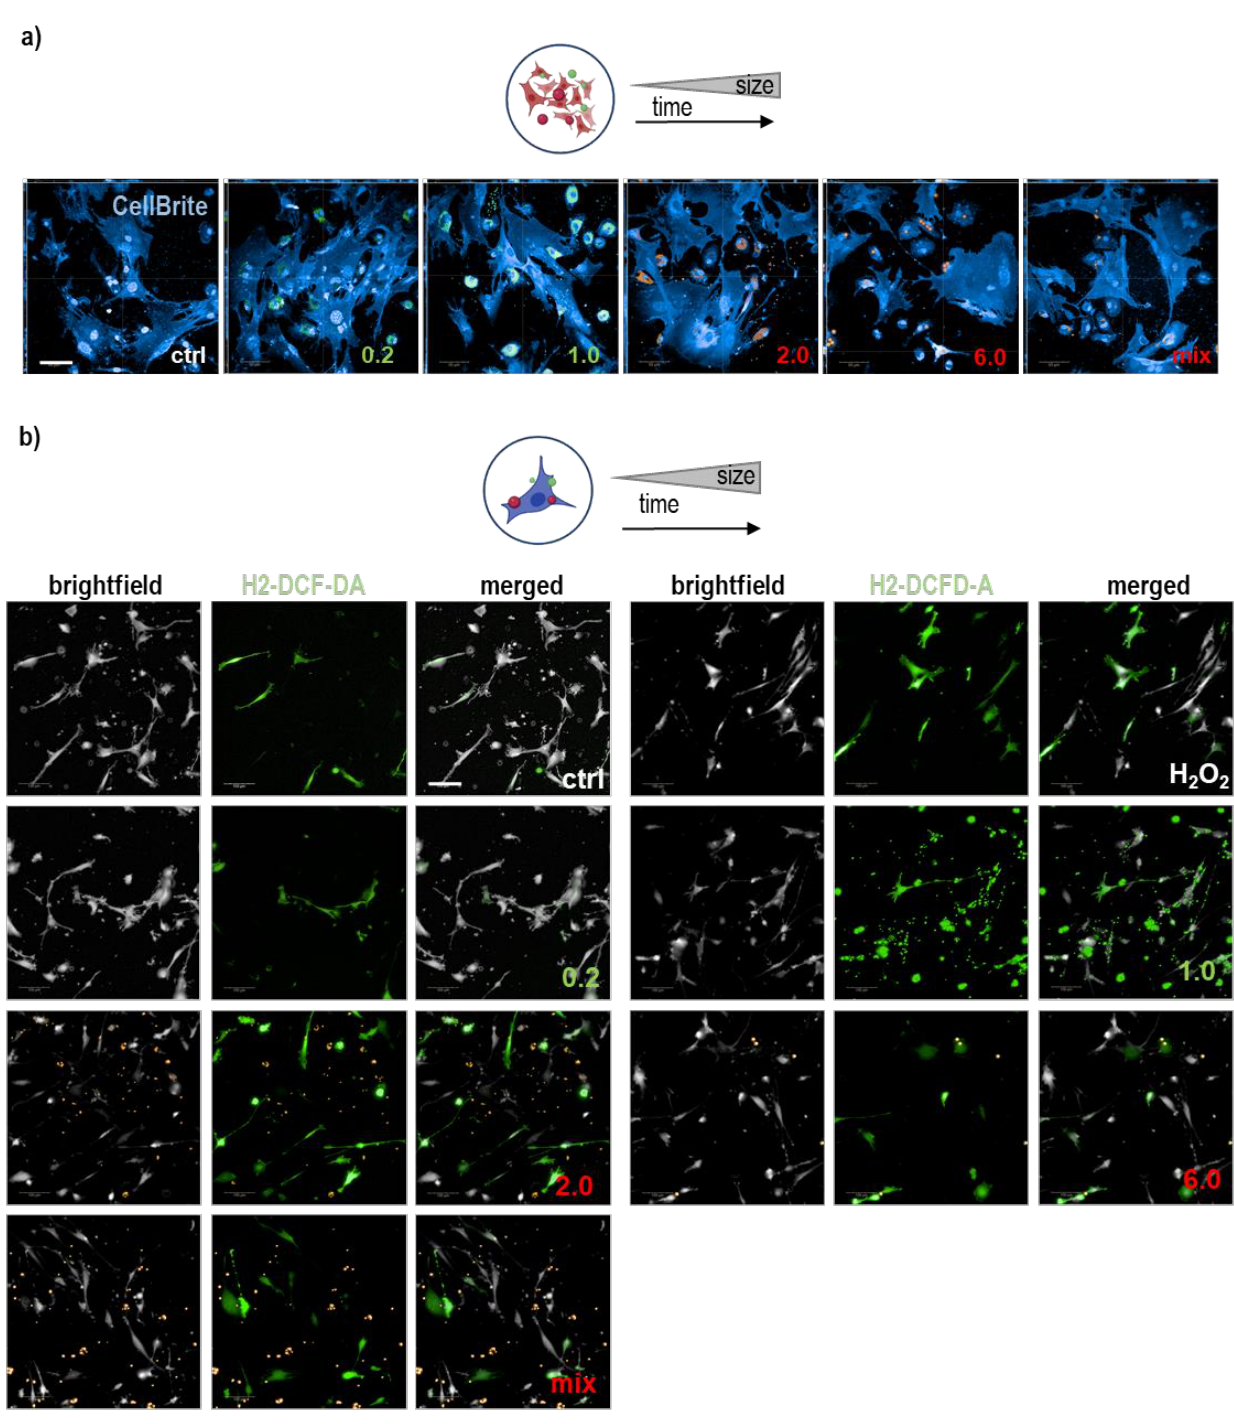
Figure A1. ( a ) Study scheme (top) and maximum intensity projection of representative images (XYZ view) of murine lung cells with cell membranes selected in blue (CellBrite) and fluorescent particles inside as well as outside of the cell in green and red (green for 0.2 and 1 µm, and red for 2.0, 6.0 µm, and mix); ( b ) representative images of H 2 -DCF-DA staining (green) in untreated (ctrl) and NMP- treated lung cells with NMP ranging from 0.2 to 6 µm and a mixture between 1 and 5 µm. Scale bars are 5 µm (Z-plane, a ) and 50 µm (X and Y planes, a , b ).